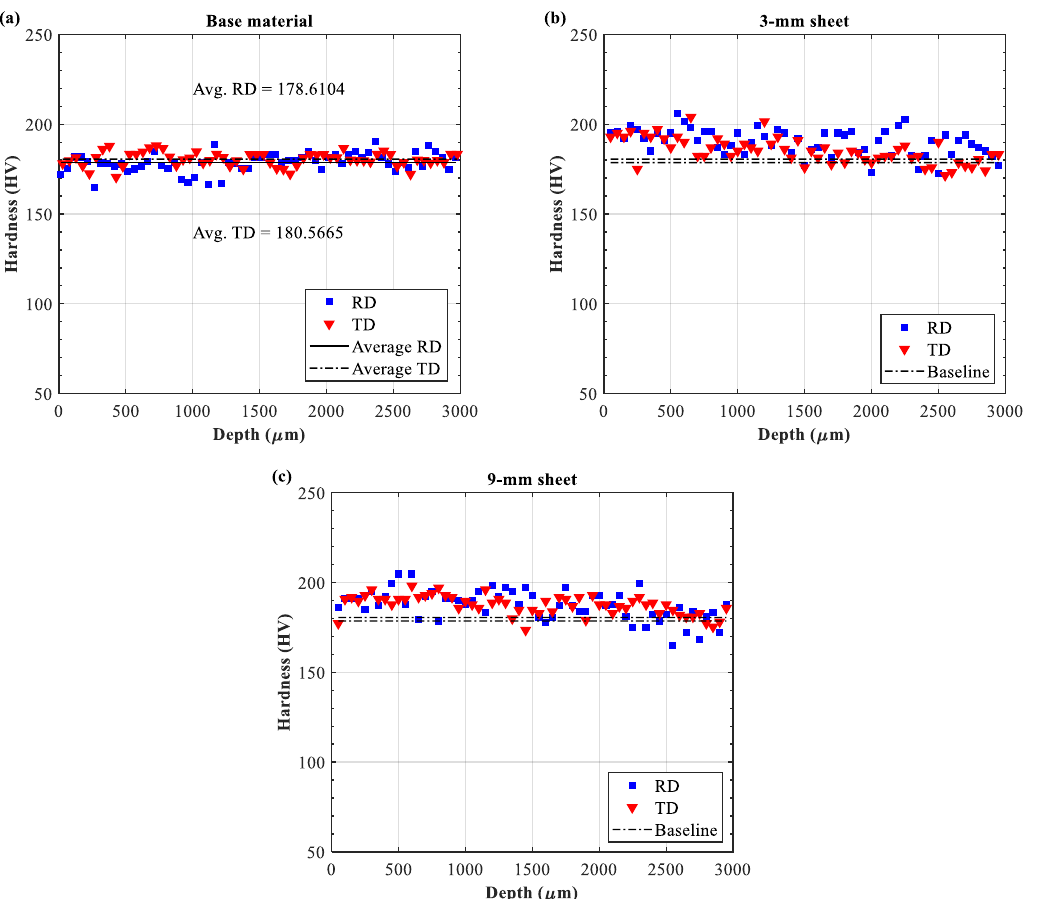
Figure 4. Cross-sectional hardness variation in the base material and the LPF sheets: ( a ) base material, ( b ) 3-mm sheet, and ( c ) 9-mm sheet.